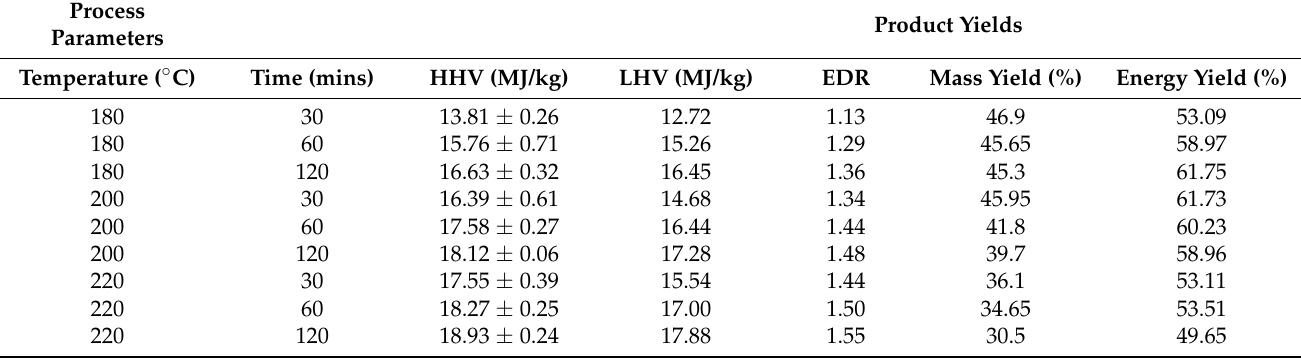
Table 2. The energy analysis of